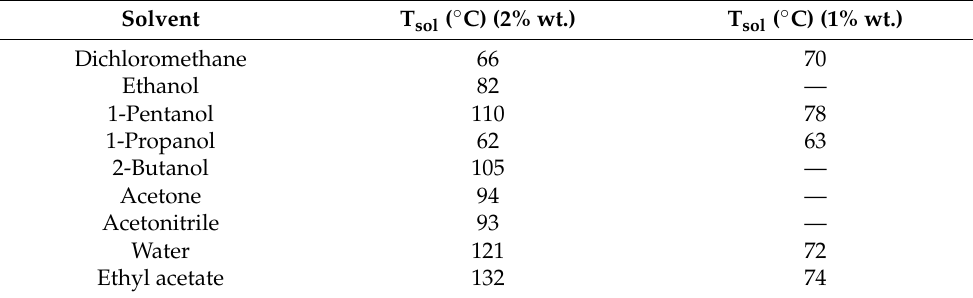
Table 2. T sol for gels of G1 at 2% wt. and 1% wt.